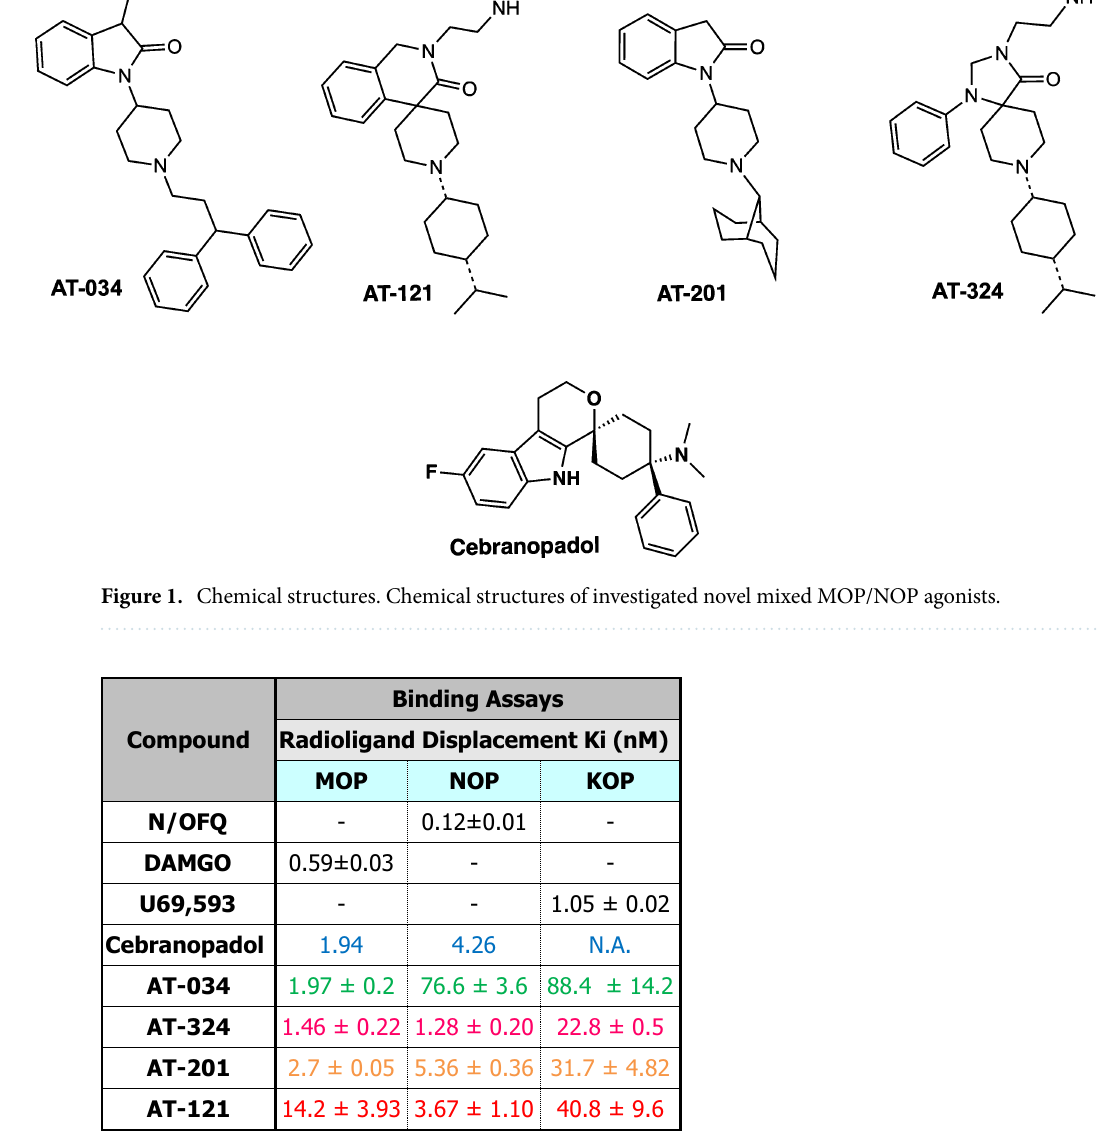
Table 1. Receptor binding of the investigated compounds in CHO cells stably expressing MOP, NOP and KOP.